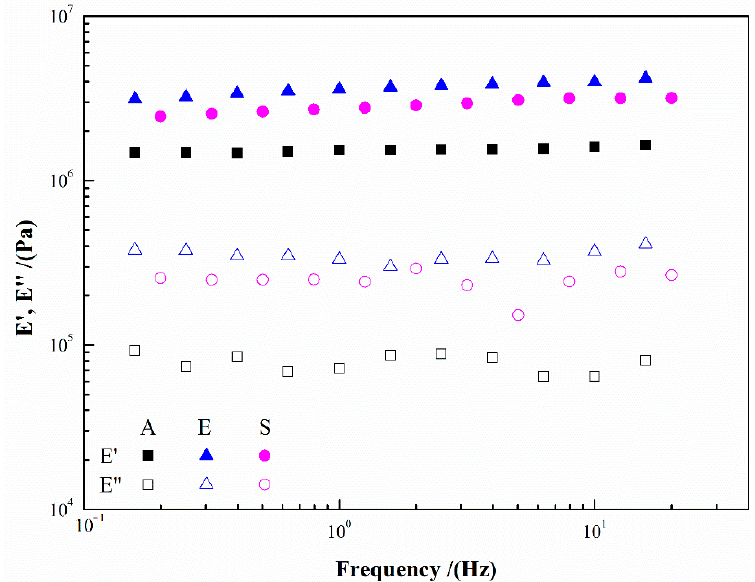
Figure 1. Elastic (E’) and viscous (E”) moduli obtained in frequency sweep tests of the matrices processed by the different protocols.